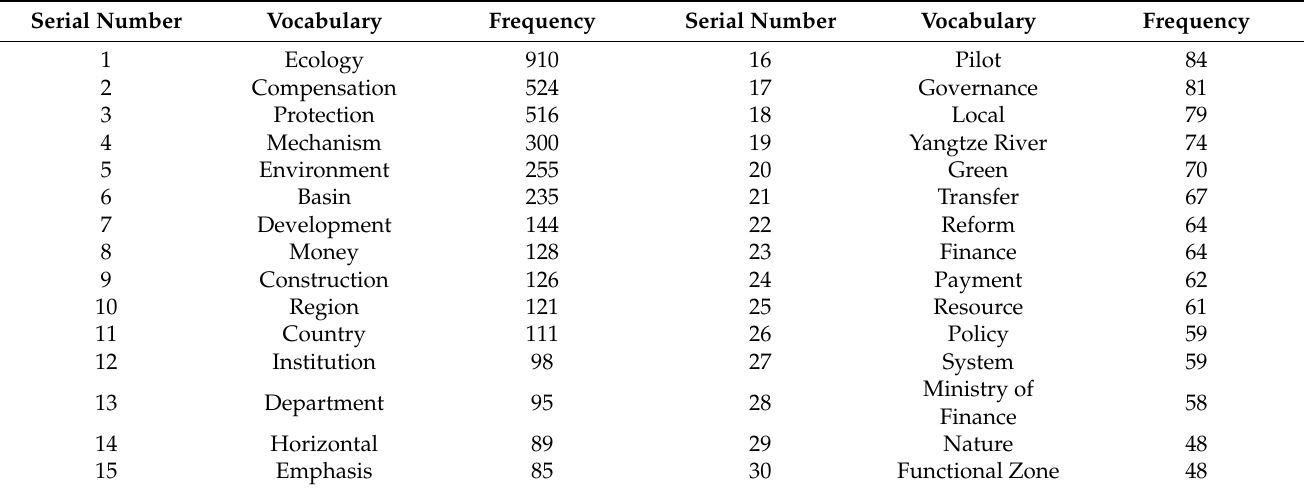
Table 2. Policy text key words’ frequency statistics